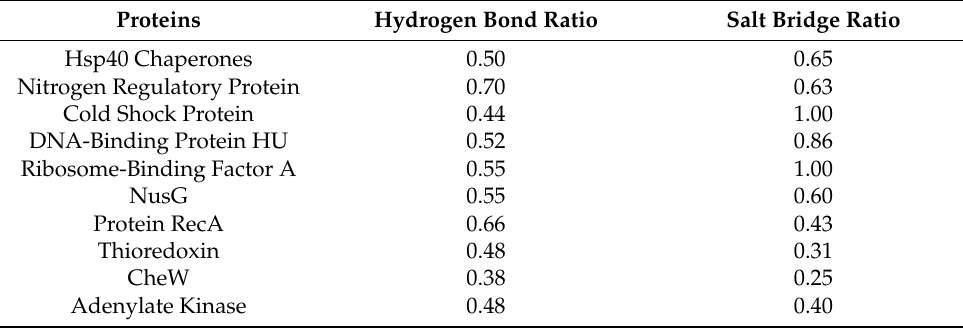
Table 2. The ratio of hydrogen bonds and salt bridges in thermophilic